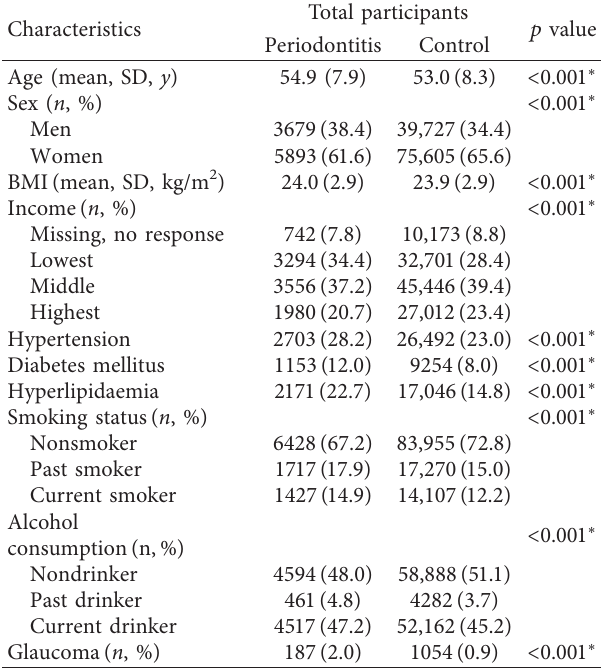
Table 1: General characteristics of